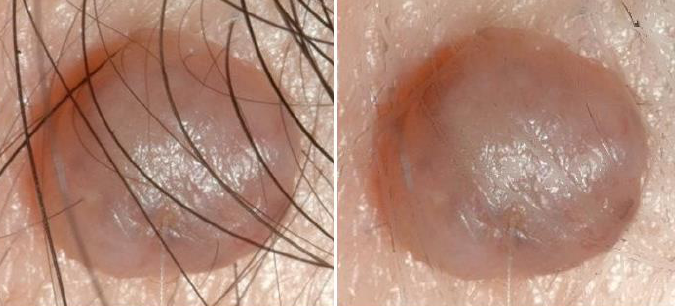
Figure 4. The image of a skin lesion before ( left ) and after ( right ) the hair removal process using the Dullrazor technique .